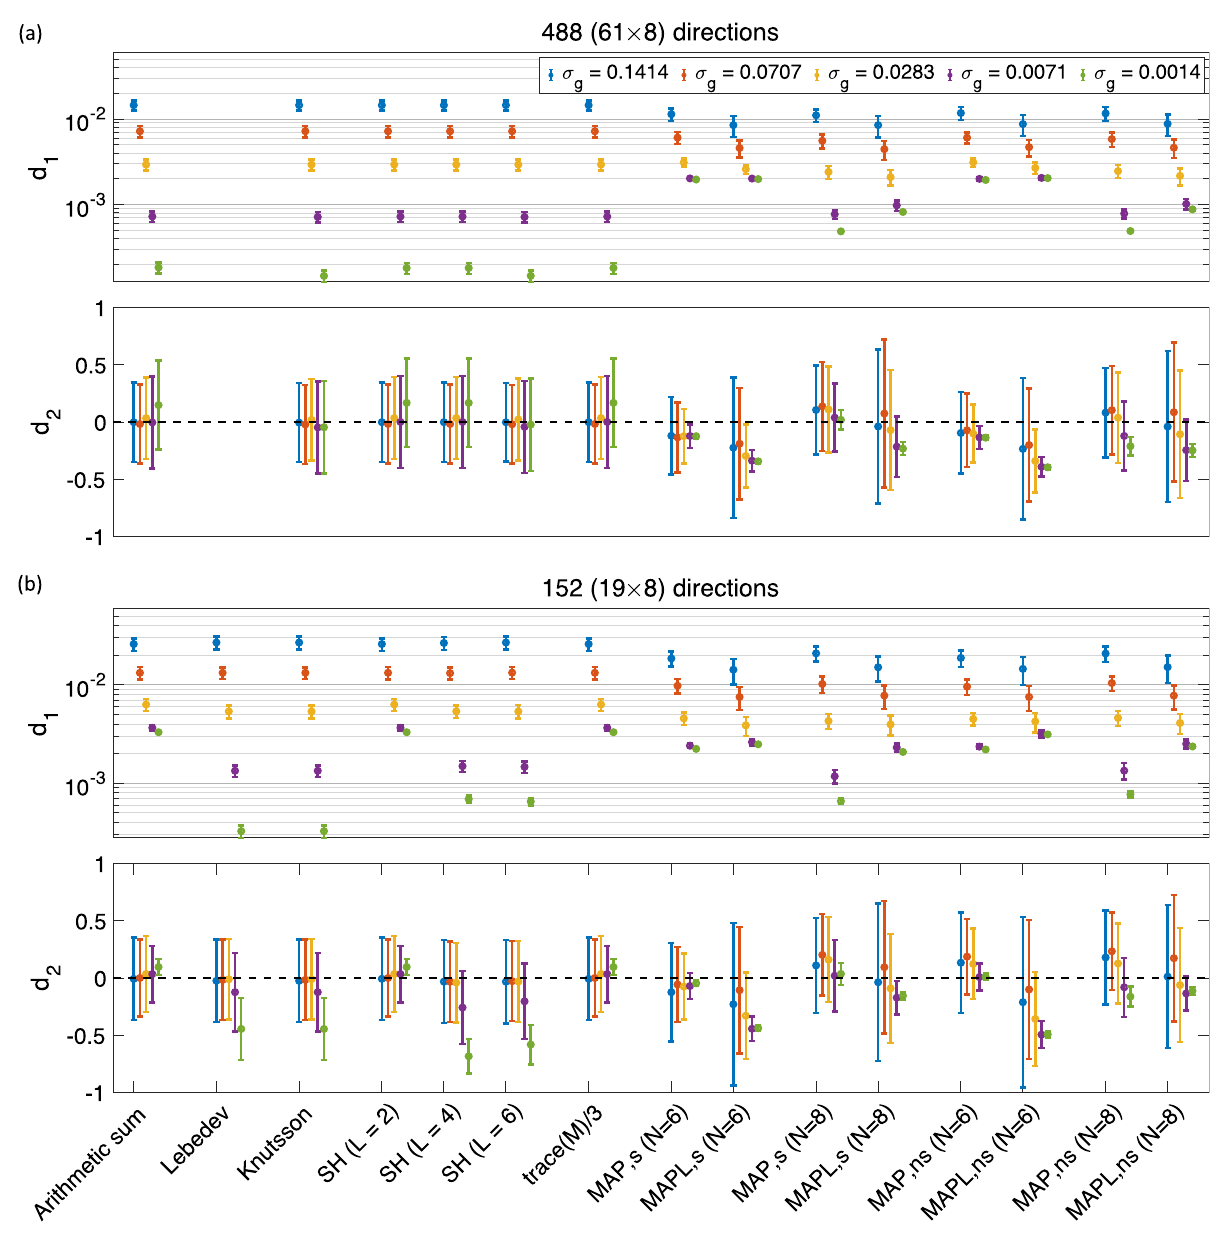
8 ) 31 directions (the y-axis in d 1 is scaled logarithmically). Arithmetic sum: simple × arithmetic averaging; Lebedev: weighted averaging by 31 ; Knutsson: weighted averaging by 43 ; SH: Spherical 2, 4, 6 , shows the order in spherical harmonic representation; harmonic method for powder averaging by 3 L = trace(M)/3: powder average signal from Eq. (10); MAP: direction-averaged signal using MAP-MRI 44 for 6 and 8; and MAPL: direction-averaged signal using MAP-MRI with Laplacian regularization 51 . The N max = ‘s’ and ‘ns’ correspond to the shelled and non-shelled point sets, respectively. Different colors (blue, red, yellow, 0.1414, 0.0707, 0.0283, 0.0071, 0.0014 purple, green) show the results in different noise levels ( σ g =